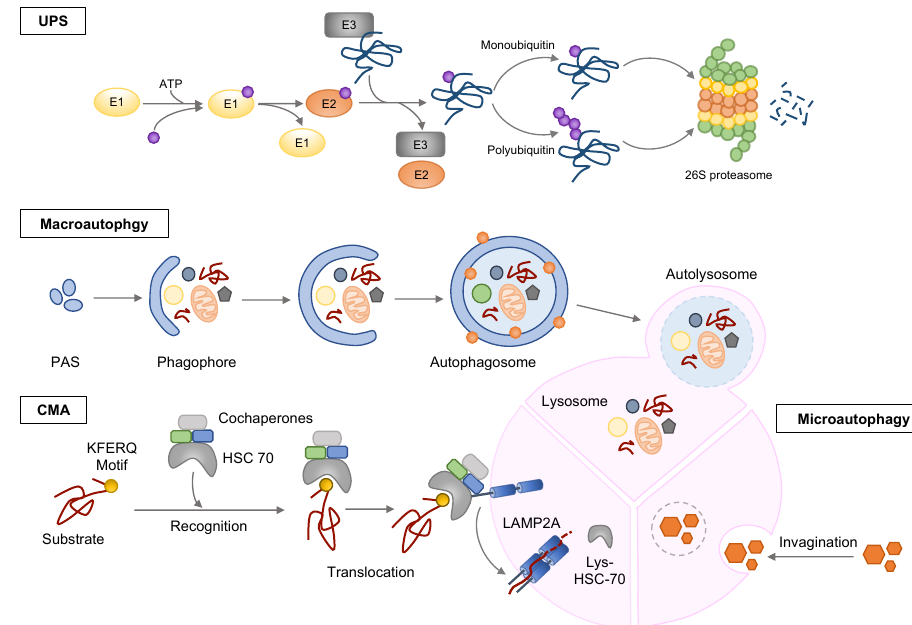
Figure 2 . Various mechanisms of protein QC